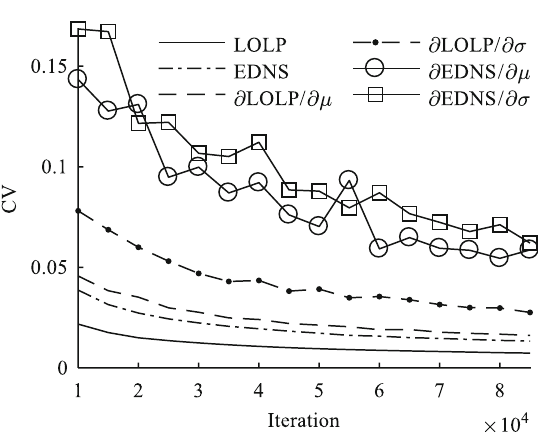
Fig. 7 CVs of reliability indices and